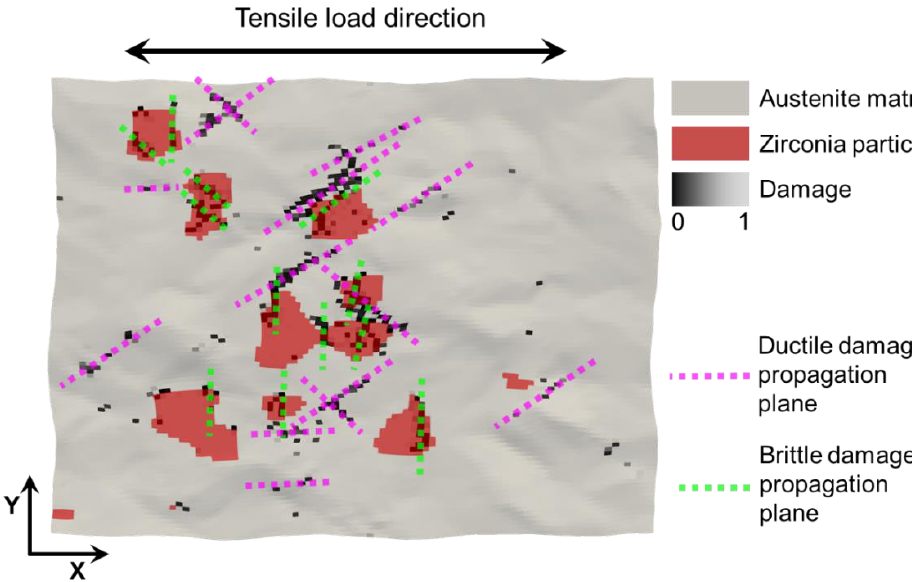
Figure 5. Virtual construction of damaged planes in austenite and zirconia phase at 16.2% of the global strain. Most ductile damage planes in the austenitic matrix (magenta dotted lines) are 45 degrees to the tensile load direction. In contrast, most of the brittle cracking planes in the zirconia particles (green dotted lines) are perpendicular to the loading axis.